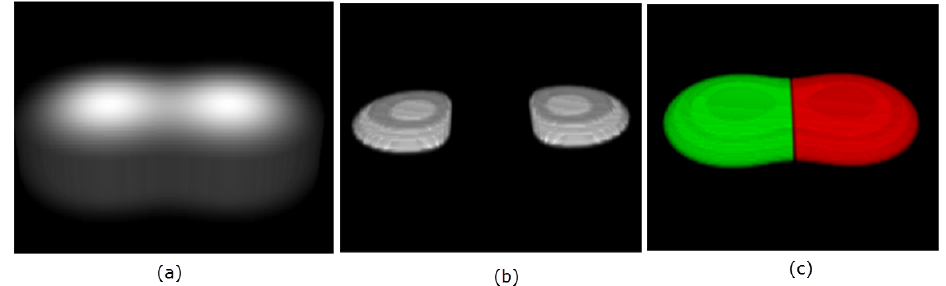
Figure 2. Panel ( a ) shows a 2D image, while panel ( b ) shows the same image as an embedded surface. In panel ( c ), the detected seeds are shown. Panel ( d ) shows the labels for the two seeds in ( c ).